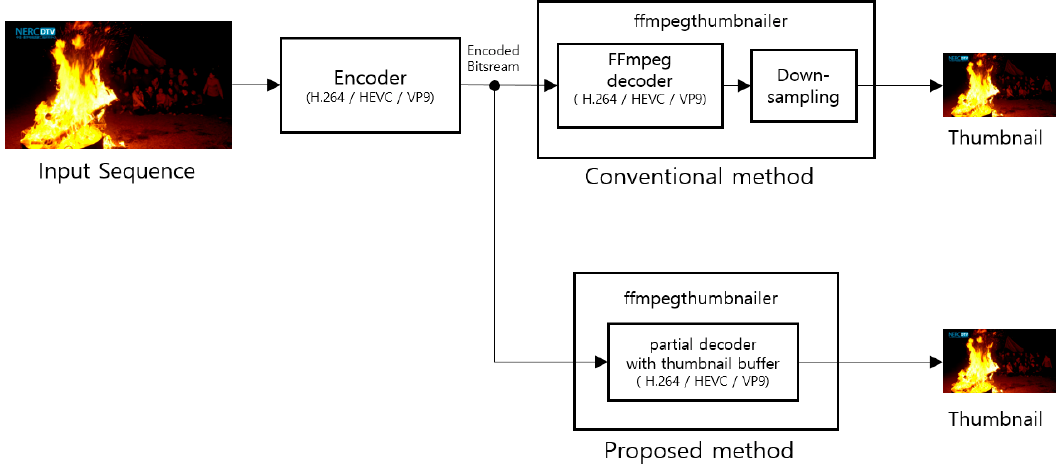
Figure 8. A block diagram for performance evaluation.